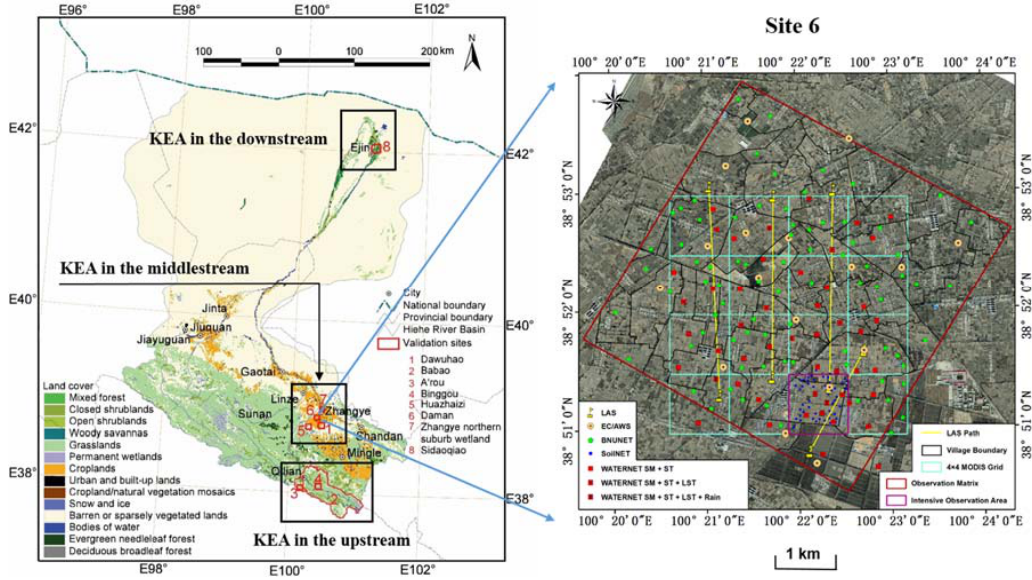
Figure 3. The setup of the EHWSN deployed in the Yingke and Daman irrigation districts in the middle stream of the HRB. The left panel shows the location, KEAs, and validation sites identified of the HRB. The right panel shows the